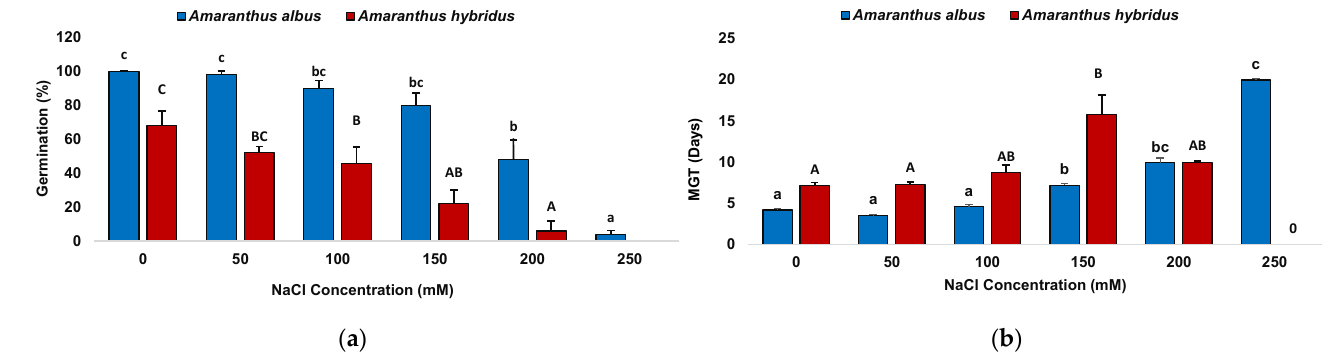
Figure 3. Final germination percentages after 14 days ( a ) and mean germination time (MGT) ( b ) in Amaranthus albus and A. hybridus , as indicated in each case . Means ± SE, n = 5. Same letters indicate homogeneous groups between treatments for each species, according to the Tukey test ( α = 0.05). Lower ‐ case letters were used for A. albus and capital letters for A. hybridus .